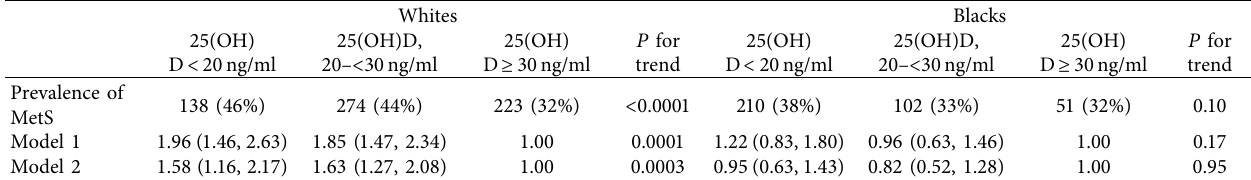
Table 2: Association between 25-hydroxyvitamin D levels and prevalent MetS at baseline in the Health ABC cohort by race.